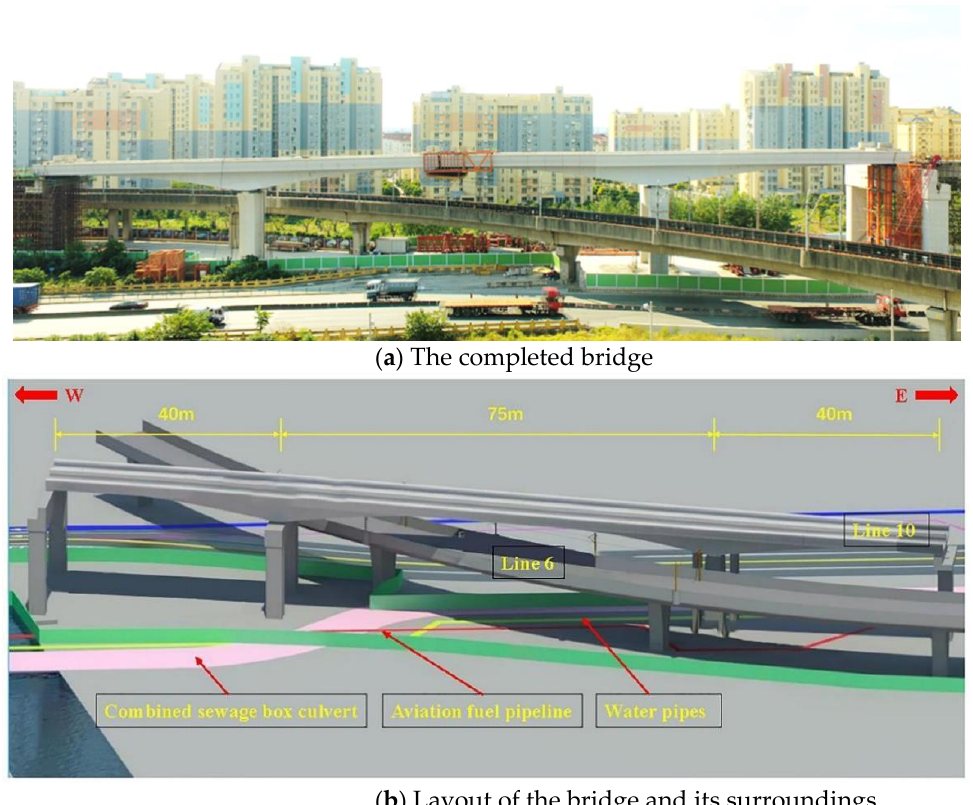
Figure 1. The bridge and its surroundings. The bridge is divided into 40 sections, as shown in Figure 3. Sections 0#~10# of the side-span to sections 0#~10# of the mid-span exist in the eastern half of the bridge. The same applies for the western half of the bridge. The pier numbers for the eastern half of the bridge and the western half of bridge are 19# and 18#, respectively. Both the 0# and 10# sections are cast in place, while the remaining sections are all pre-cast sections. During the construction process, the eastern half of the bridge is first constructed into a T-shape structure. The bridge erection machine is then erected on the T-shape structure. Sections 1#~9# are lifted in sequence by the bridge erection machine. After the completion of the eastern half of the bridge, the bridge erection machine moves to the western half of the bridge on the beam, which is referred to as the pass-hole stage. Similarly, the construction of the western half of the bridge is completed. Finally, the construction of the eastern half and the western half is closed. As the bridge erection machine should assist the bridge construction on the T-structure, the bending moment of the beam caused by the leg load should be adjusted in balance using the mechanical state control